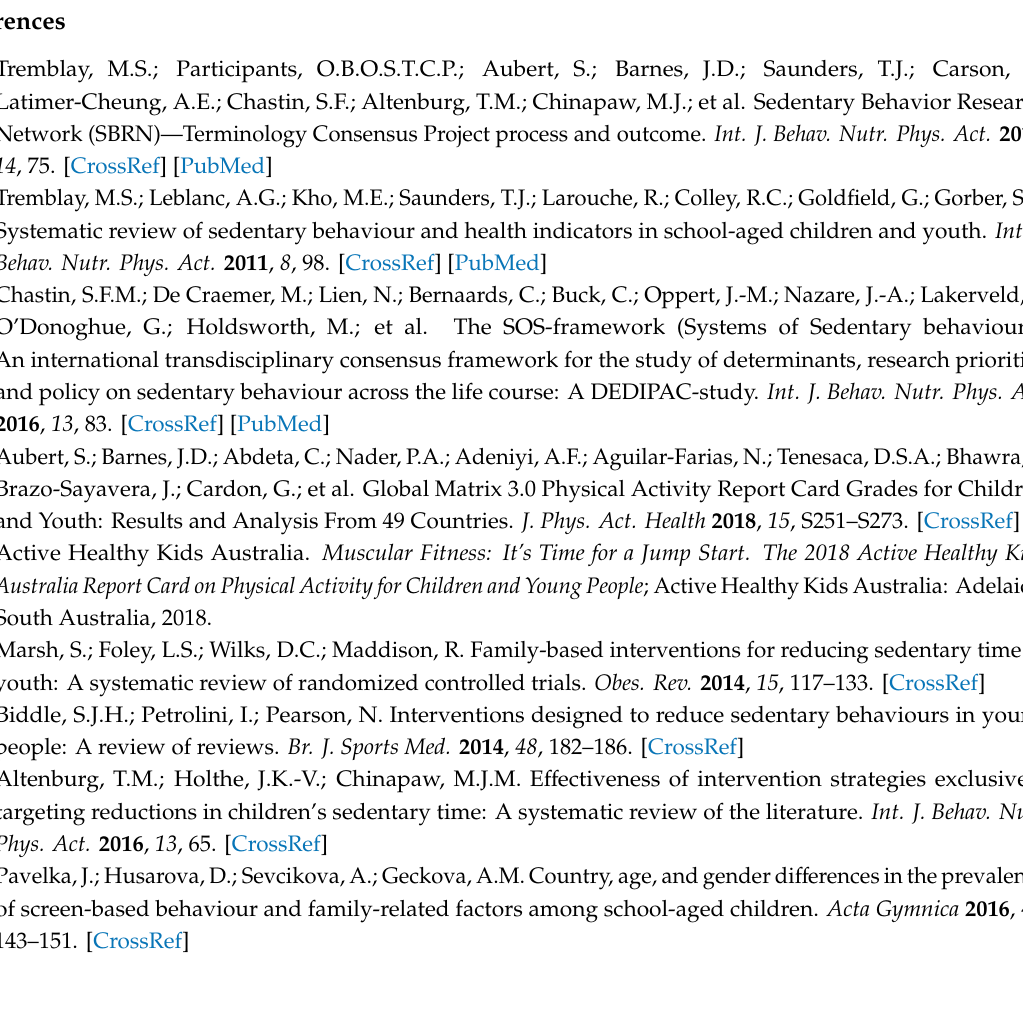
Table S1: Average (minutes / day) weekday and weekend day sitting behaviours amongst children and